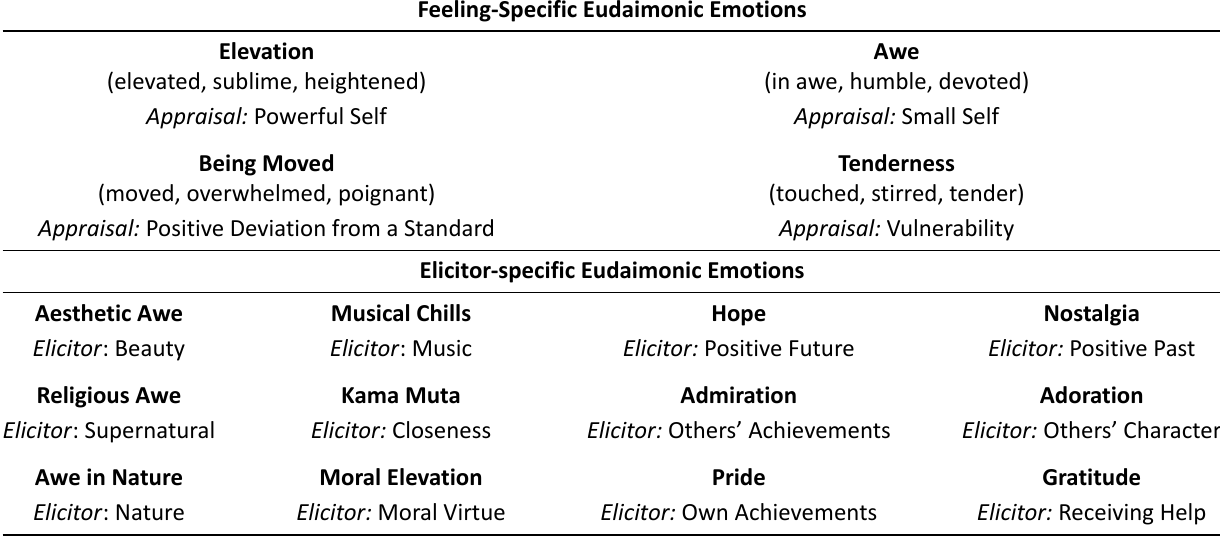
Table 1. A framework of eudaimonic (appreciative)